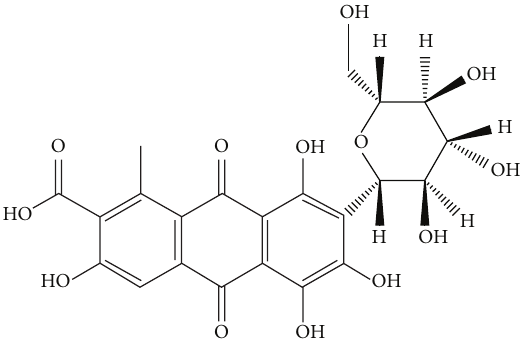
Figure 1: Carminic acid.